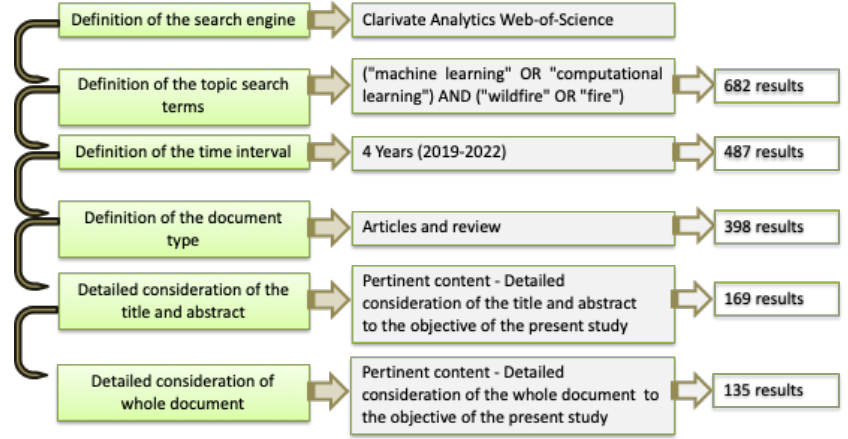
Figure 1. Schematic of search method and obtained results for each document filtering stage.